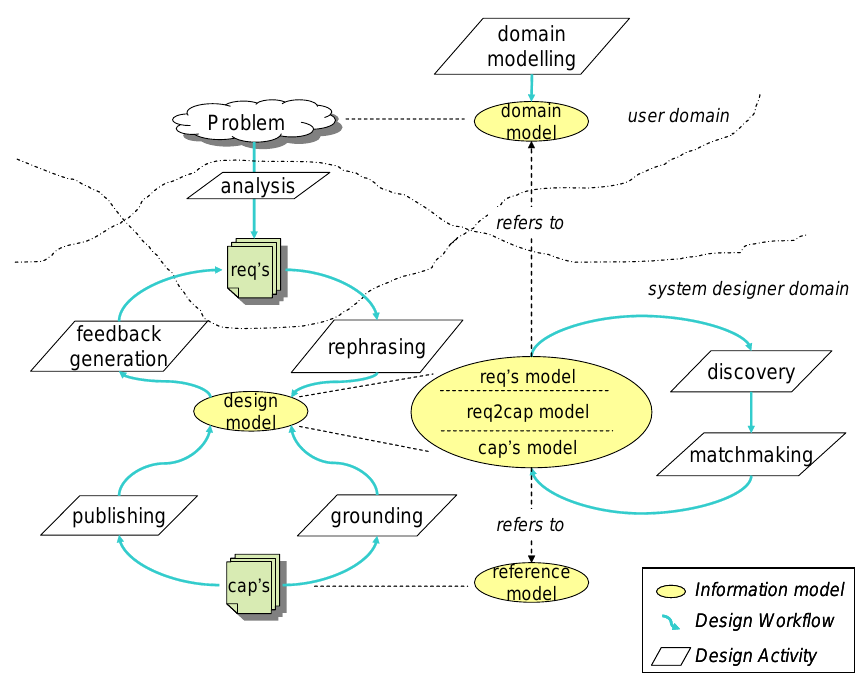
Figure 4. SERVUS analysis and design activities [4].